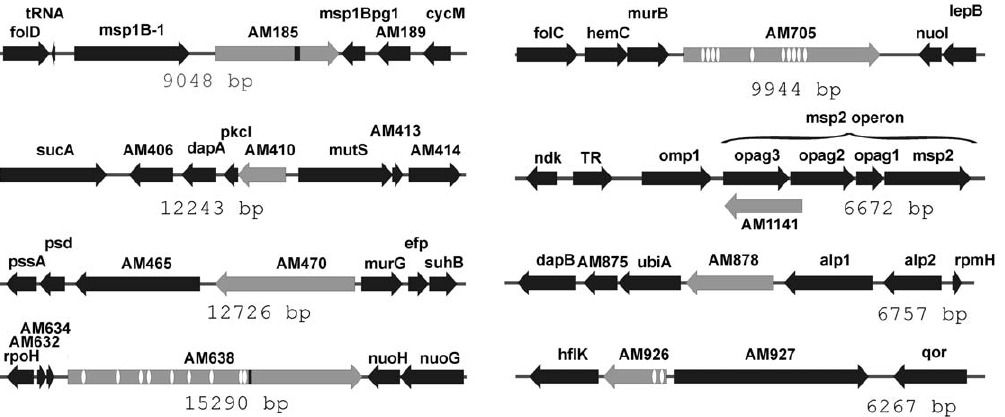
Figure 1. Genomic arrangement of genes tested in this study. The gene of interest is highlighted in gray. Beginning positions for each indicated region are: AM185 - 152987, AM410 - 361688, AM470 - 416086, AM638 ( ankC ) - 570776, AM705 ( ankA ) - 636928, AM1141 - 1025923, AM878 ( aaap ) - 806001, AM926 ( ankB ) - 843819. Numbers (bp) under each locus indicate the length of each depicted region. The white ovals indicate positions of ankyrin repeats, and black bars indicate the coiled coil domains.